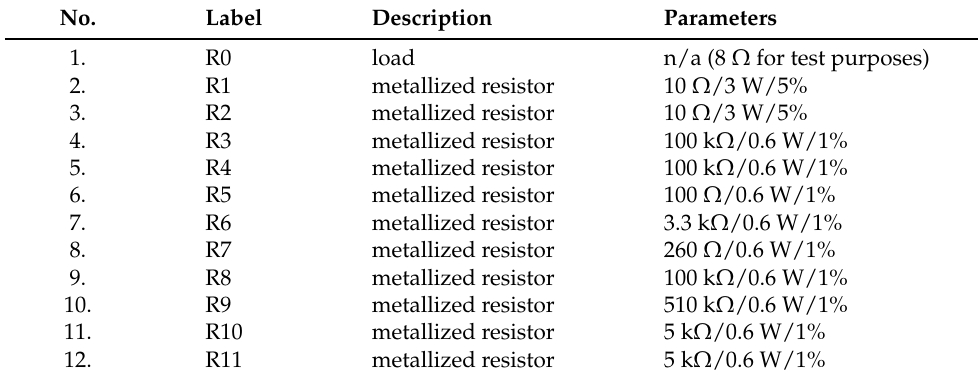
Table A1. Component list of a proposed LF semiconductor